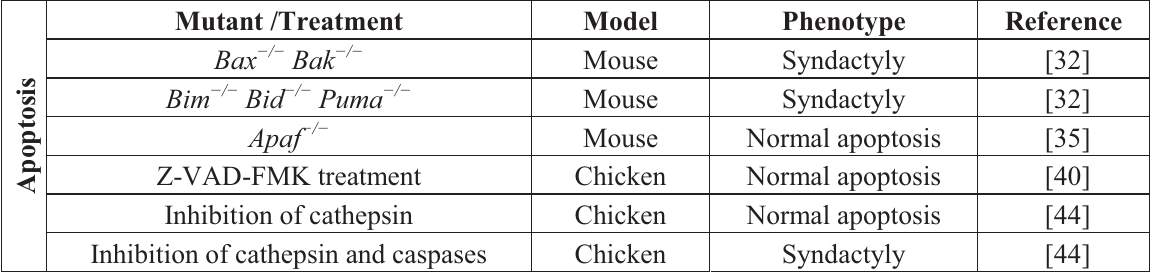
Table 1. Phenotypes observed in mutant mice for genes related to cell death or in embryonic chick limbs treated with inhibitors of caspases and cathepsins or both (see text for details).